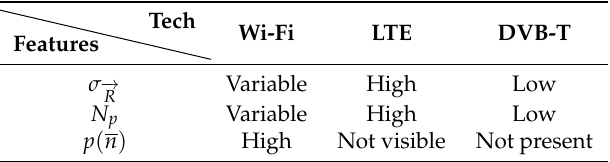
Table 1. The features vs.